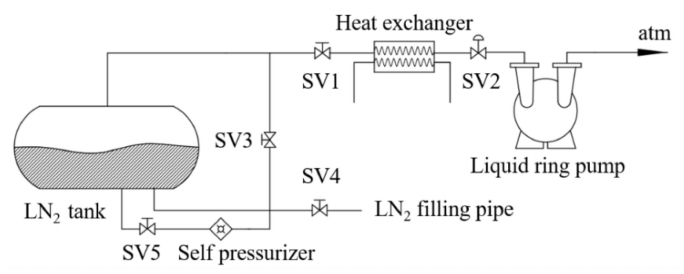
Figure 2. Schematic diagram of the liquid-nitrogen vacuumed subcooling